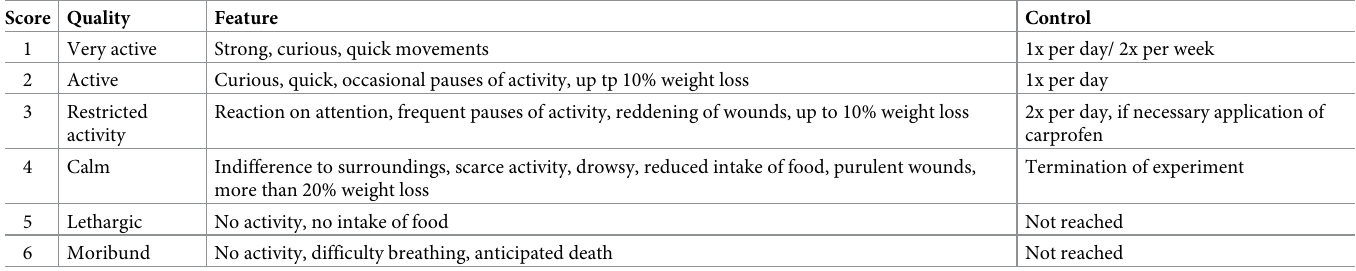
Table 1. Scoring of animals in experiment depending on activity.